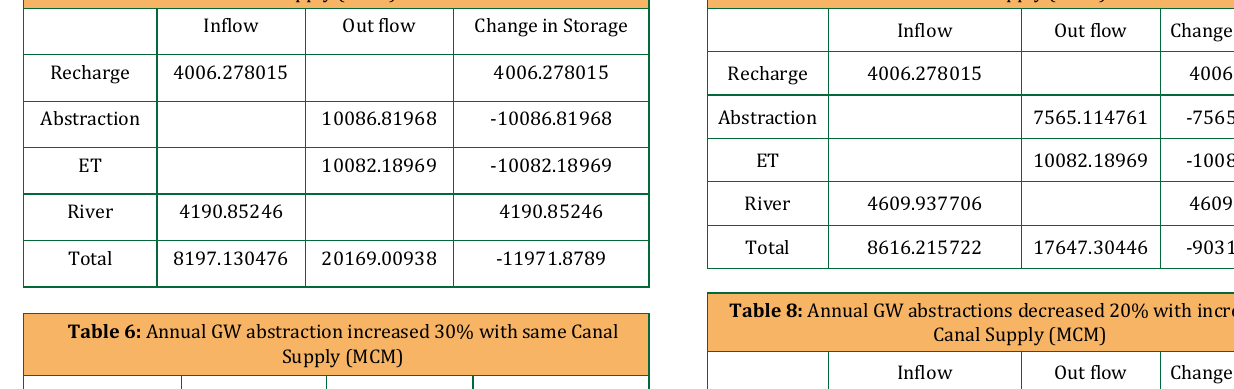
Table 5: Annual GW abstraction increased 20% with same Canal water supply (MCM)